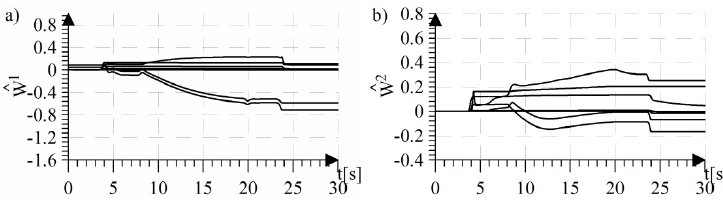
Figure 5: The course of the angular velocity of the driving wheels and value of the weight of conclusions of the rule